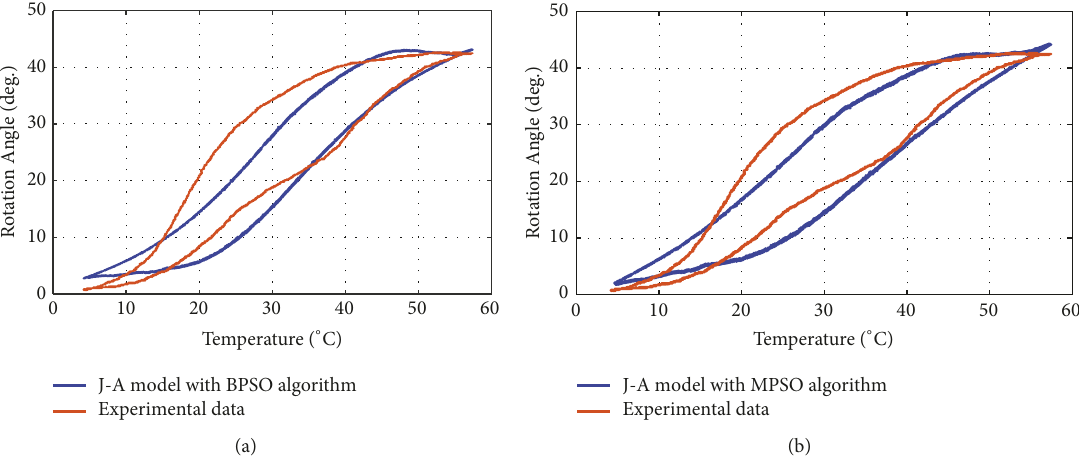
Figure 7: Comparisons of output-input responses between the Jiles-Atherton model with PSO identification algorithm and the measured data (red line: measured data; blue line: J-A model with basic PSO): (a) with basic PSO algorithm and (b) with modified PSO